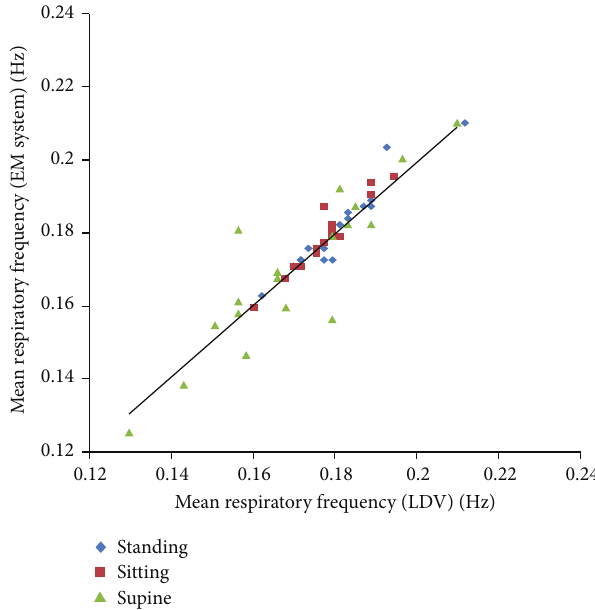
Figure 8: Scatter plot of mean respiratory frequencies ( 𝑓 𝑅 ): LDVi versus proposed method (subject position: standing, sitting, and supine).